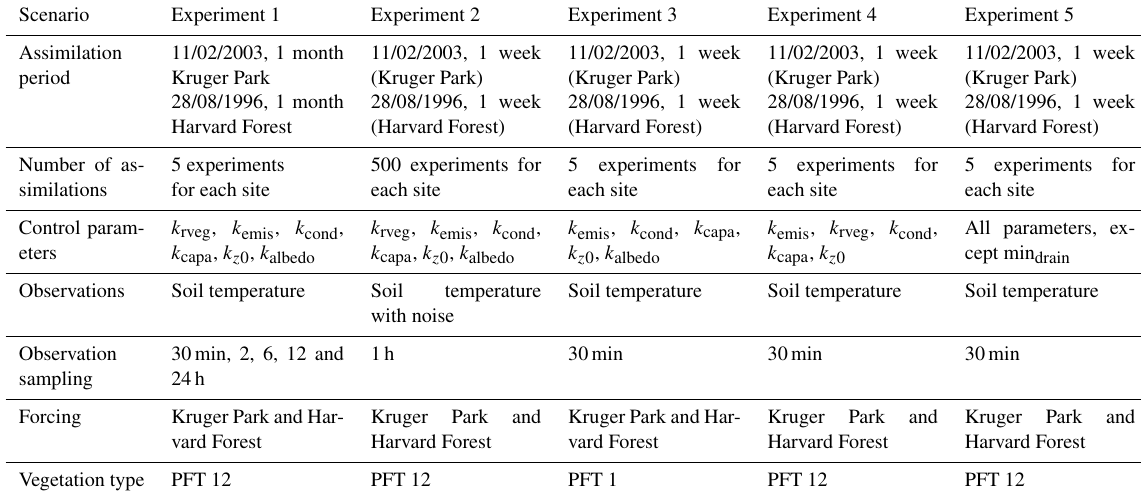
Table 4. Characteristics of the scenarios for each of the twin experiments.